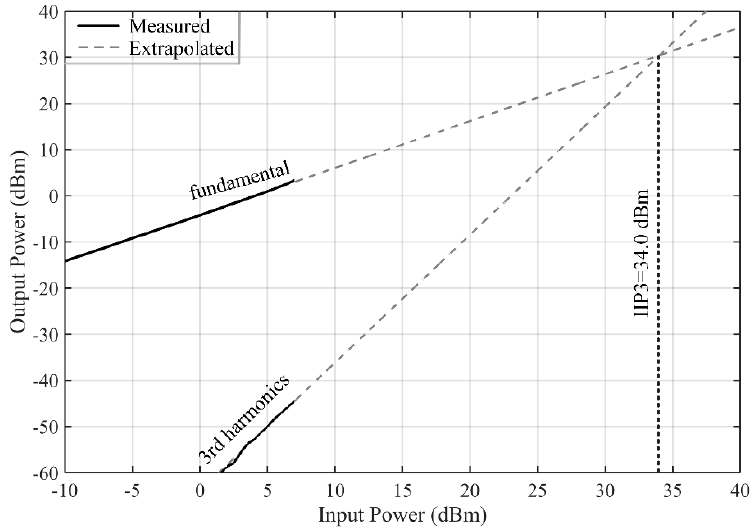
Figure 6. Third-order intercept point (IIP3) measurement at 2.4 GHz.